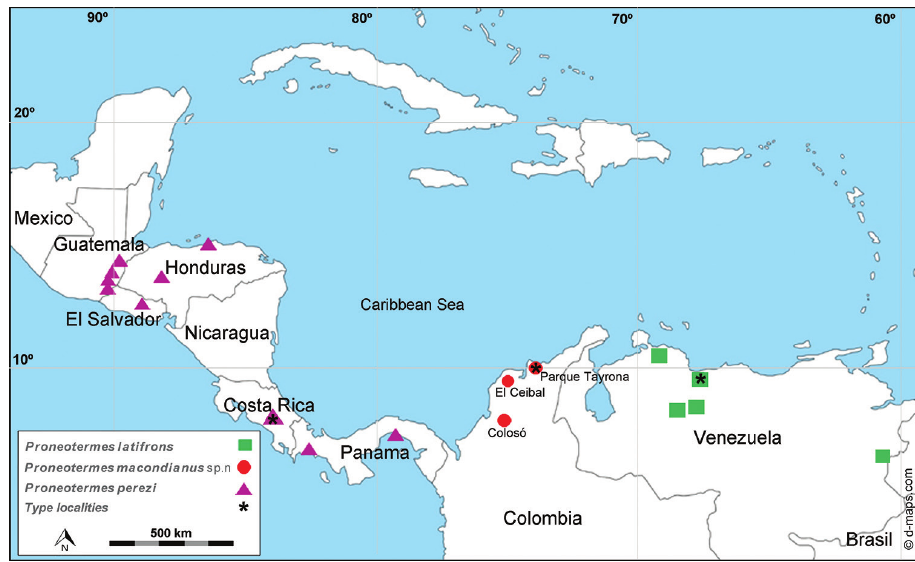
Figure 1. Sampling localities for Proneotermes macondianus sp. n in Colombia and new records from University of Florida collection for P. latifrons and P. perezi